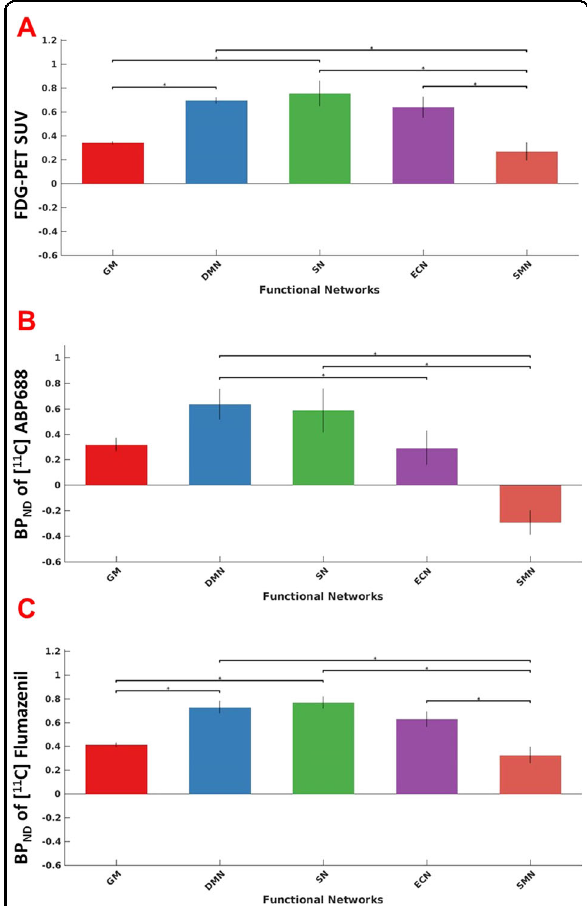
Fig. 5 PET measures within resting-state networks. Bar plots showing FDG-PET SUV ( A ) and the distribution of neuroreceptor availability of mGLUR5 ( B ) and GABA A ( C ) in whole-brain grey matter (GM), default mode network (DMN), salience network (SN), executive control network (ECN) and sensory motor network (SMN). The error bars show the standard deviations. The horizontal markers with an asterisk symbol show the signi fi cant differences between regions based on the Dunn ’ s